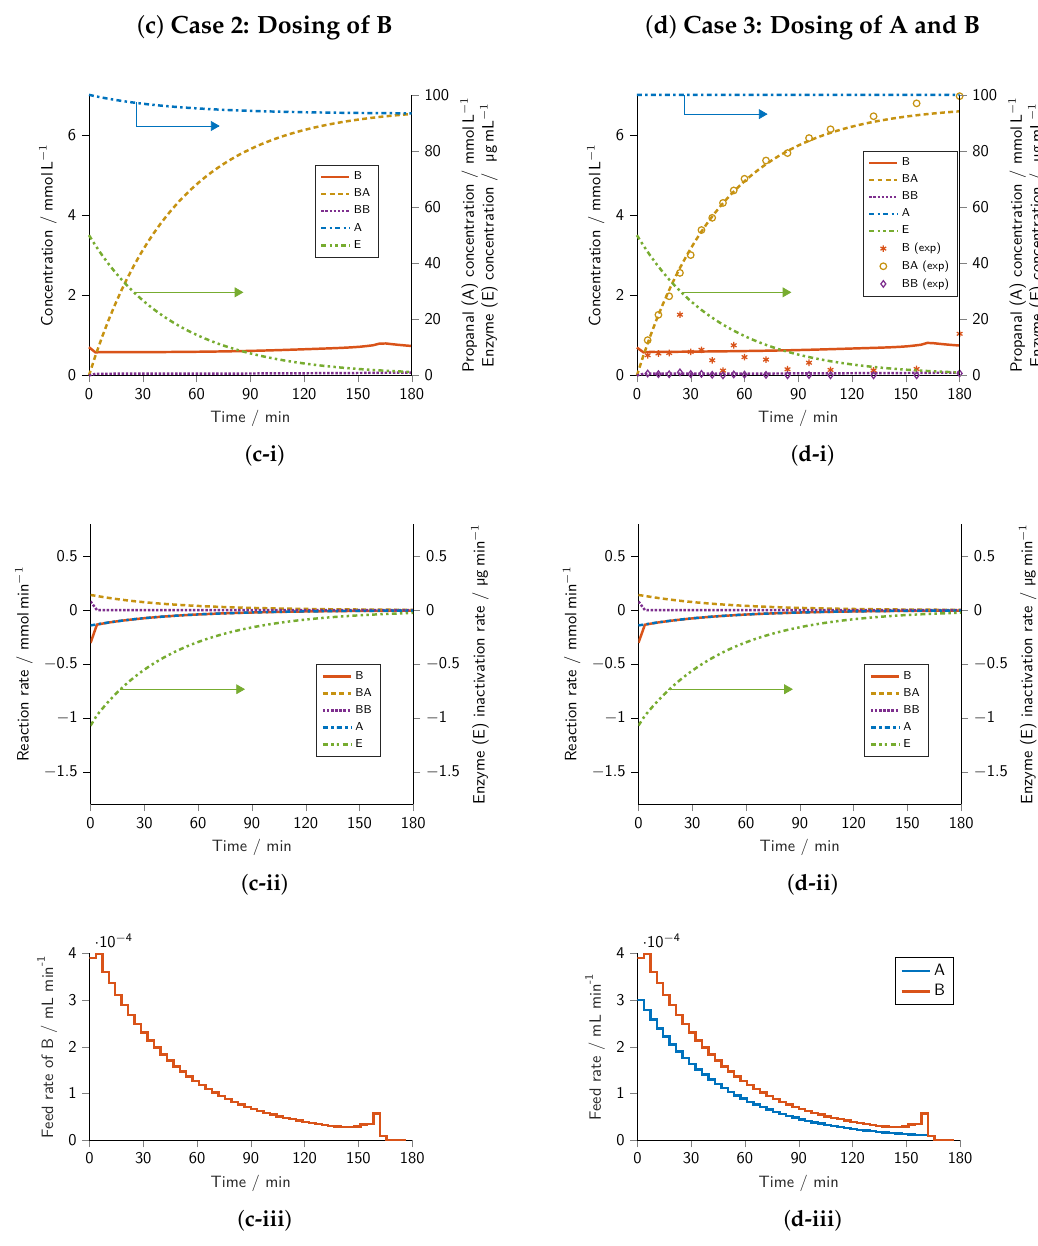
Figure 2. Results of the dynamic optimization and their experimental verification. Columns: ( a ) Batch reference, ( b ) Intensification Case 1 involving the dosing of A, ( c ) Intensification Case 2 involving the dosing of B, and ( d ) Intensification Case 3 involving the dosing of A and B. Rows: ( i ) concentration profiles, ( ii ) reaction rate profiles, and ( iii ) volumetric flow rate profiles. Starting concentrations within the design space were optimized so that the concentration of BA at final time point t f = 180min was maximized. Lower concentration bounds were defined as 0mmolL − 1 and upper bounds as 100, 149.35, 2.78mmolL − 1 , and 50µgmL − 1 for A, B, BB, and E, respectively. Experiments were conducted at 30 ◦ C in a reaction volume of 30mL (70% v / v TEA buffer with cofactors and 30% v / v DMSO) at pH = 8.5. Batch reference: C BA,sim ( t f ) = 5.83mmolL − 1 , C BA,exp ( t f ) = 5.40mmolL − 1 , Case 3: C BA,sim ( t f ) = 6.59mmolL − 1 , C BA,exp ( t f ) = 6.97mmolL − 1